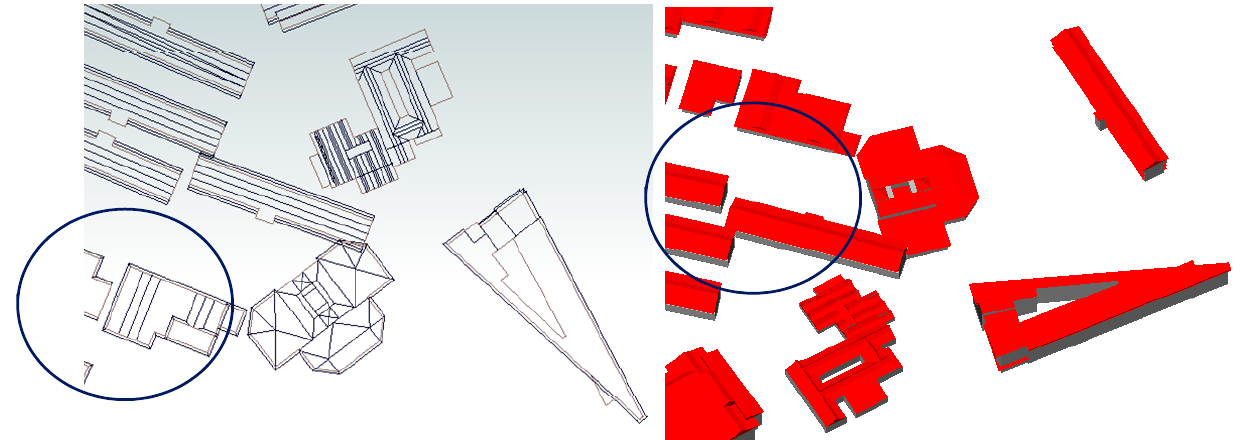
Figure 15. Example of inaccurate positioning of buildings in 2D and 3D.